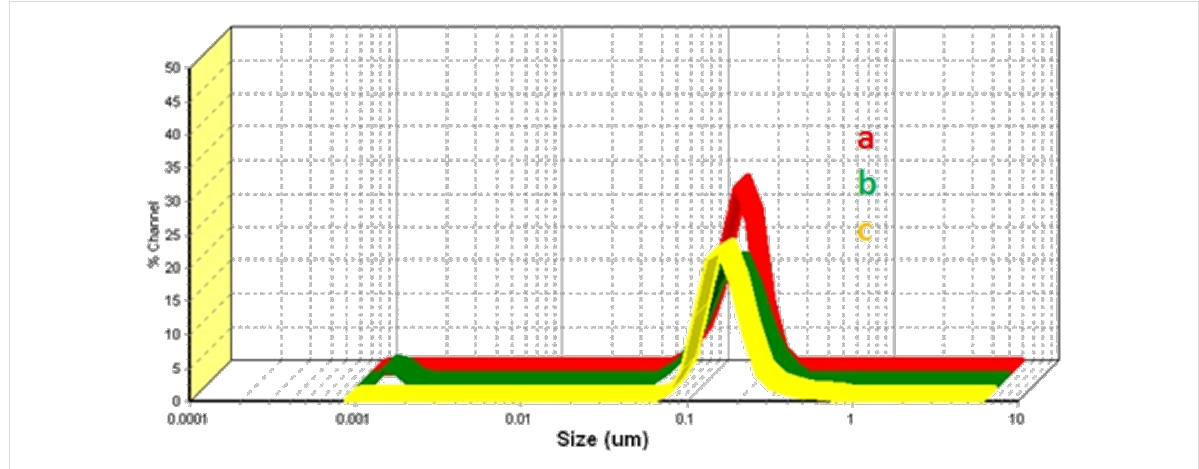
Figure 4: Particle sizes and distributions of Ta 2 O 5 synthesized from (a) Ta(O n -Bu) 4 (OOCCH 2 Cl), (b) Ta(O n -Bu) 4 (OOCCHCl 2 ) and (c) Ta(O n - Bu) 4 (OOCCCl 3 ).